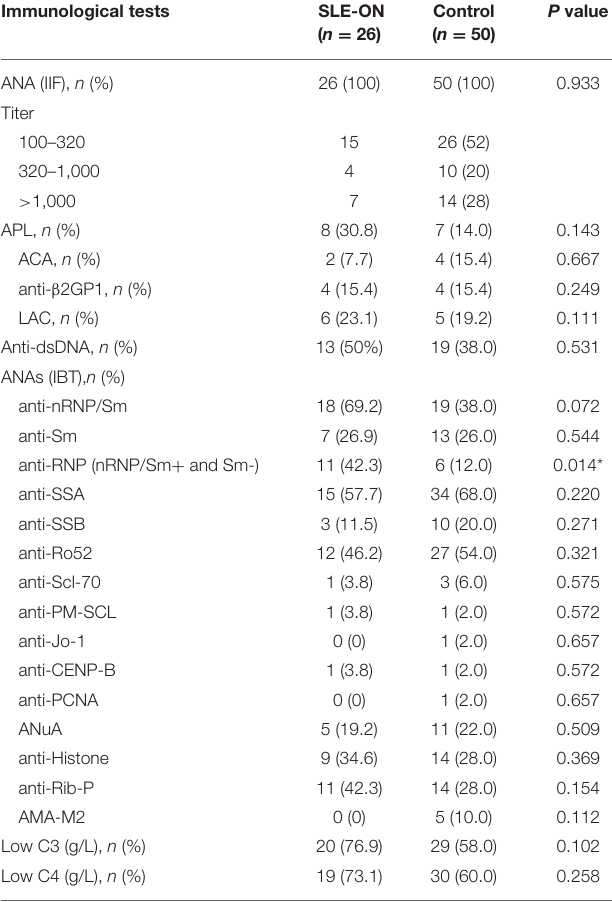
TABLE 2 | Immunologic features in the SLE-ON group and control group. Immunological tests